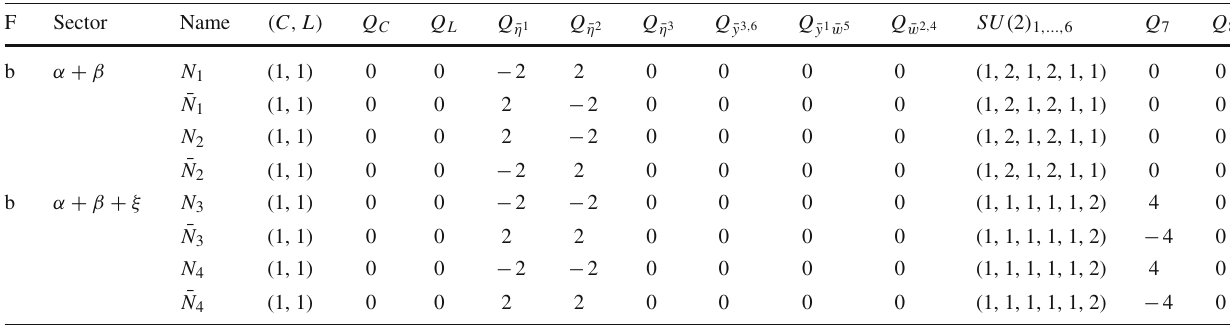
Table 5 SO ( 10 ) singlets without ˜ S -partners. All charges are multipled by 4 and the combination ζ = 1 + b 1 + b 2 + b 3 has been